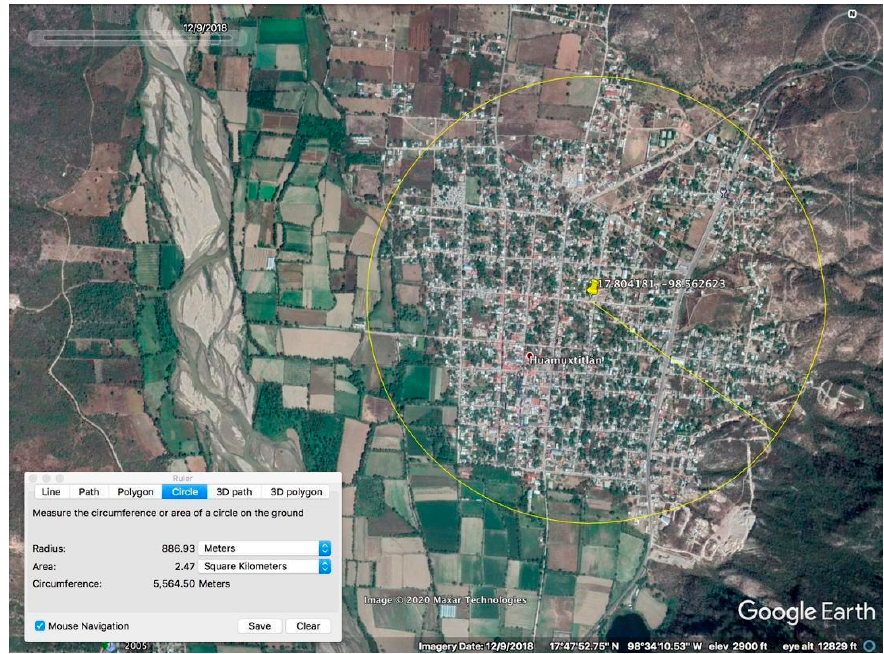
Figure 3. Unique geofences were manually constructed around the control and experimental communities, such as the 867-m buffer around Huamuxtitlán, Guerrero of Huamuxtitlán.